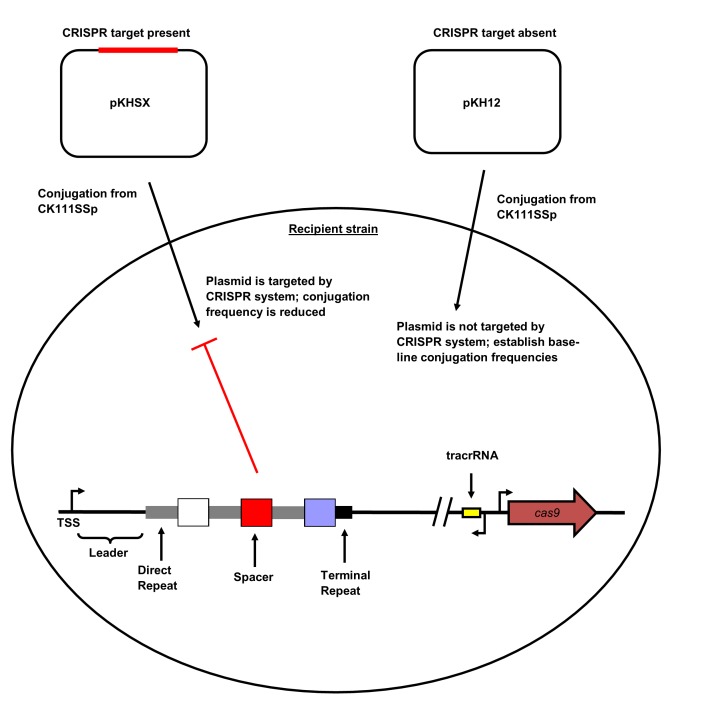
CRISPR2 locus architecture and conjugation experiment setup.Direct repeats are shown as grey rectangles and spacers are shown as squares. The terminal degenerate repeat is shown as a short black rectangle. The region between the TSS and the first repeat is known as the leader. A functional CRISPR system will reduce the conjugation frequency of pKHSX relative to pKH12. pKHSX contains the spacer X sequence and the NGG PAM motif, where X defines the specific spacer sequence from our previous typing system.